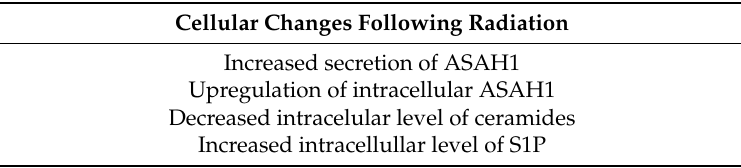
Table 2. Cellular changes in GBM following radiations are